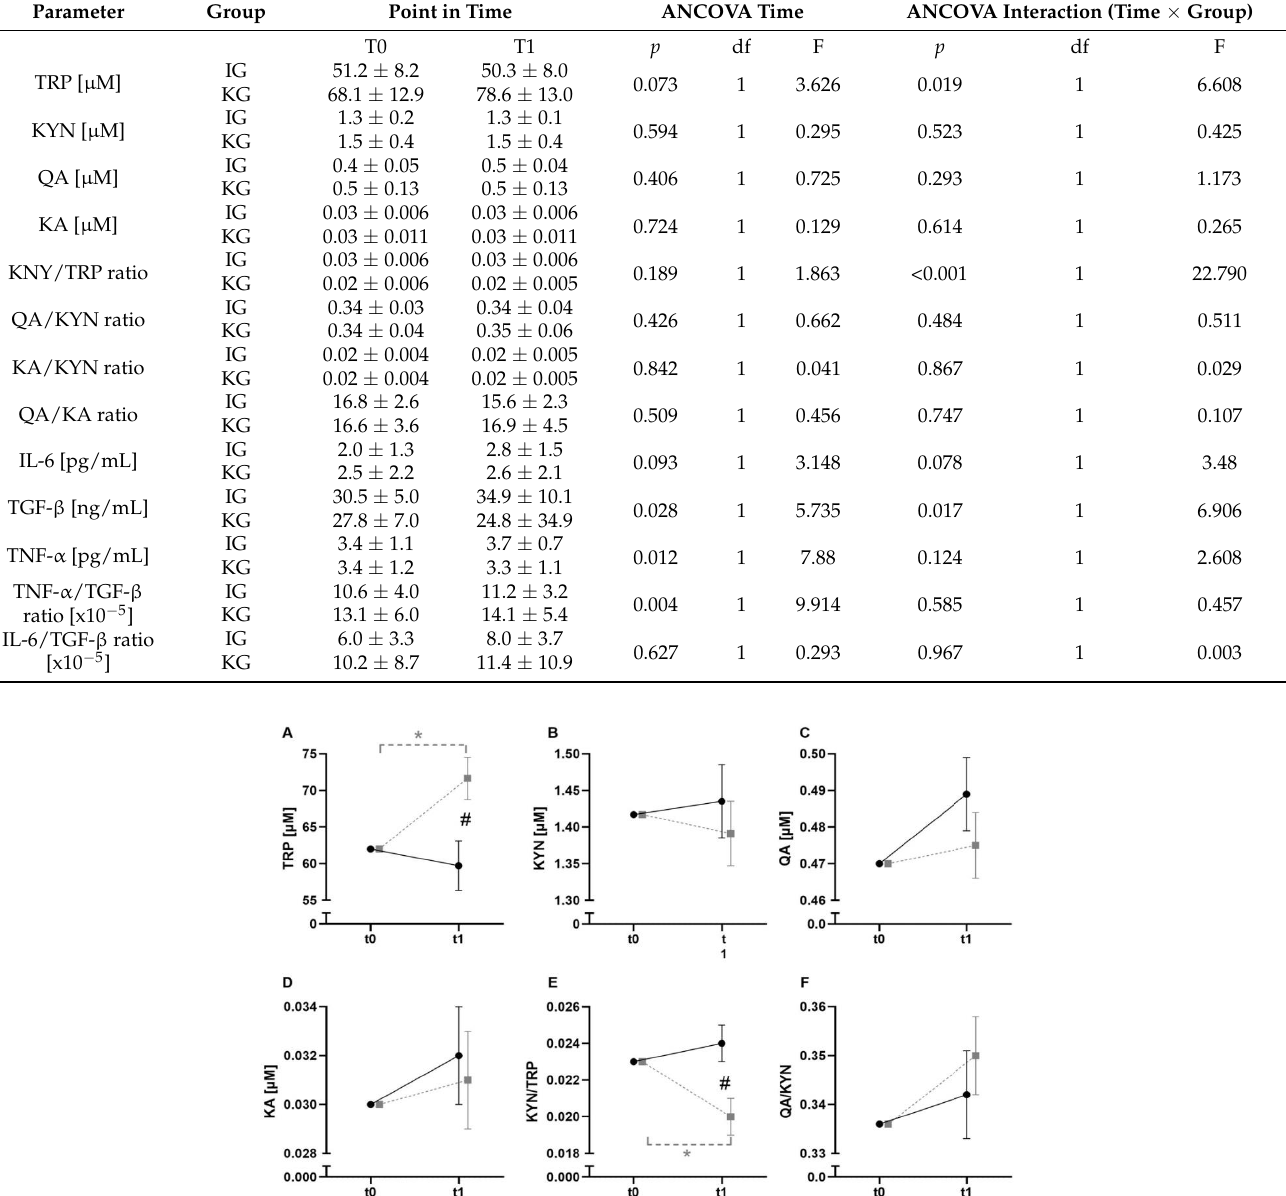
Table 2. Intervention effect on the KYN pathway and inflammatory markers. Data are presented as mean ± SD. The main effects of the baseline adjusted ANCOVA are time and interaction effects.